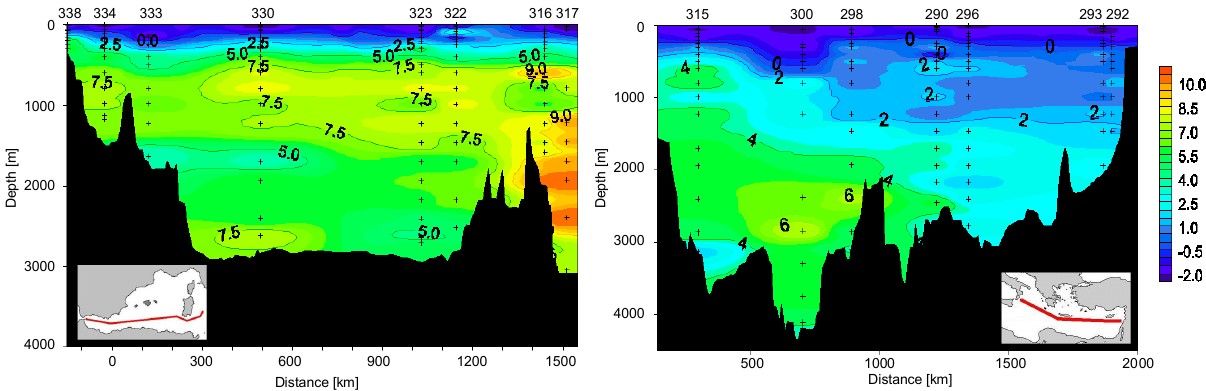
Fig. 9. δ 3 He sections (%) of Meteor M84/3, 2011, left WMed, right EMed. Numbers on top are station numbers, sections cf. inset maps. The track in the EMed part differs from that in Fig. 5 because, close to Sicily, He and tritium were sampled on different stations.